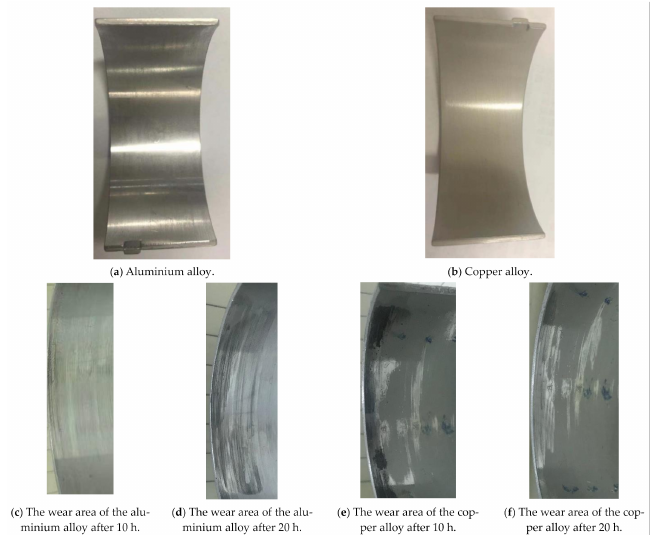
Figure 11. The bearing pictures after the